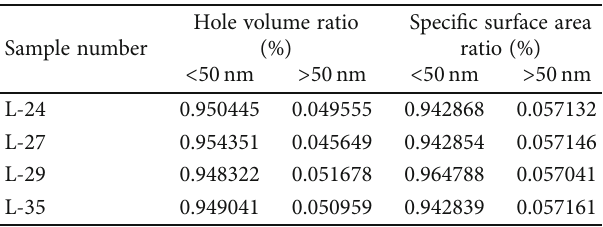
Figure 6: Stratigraphical distribution of the pore volume. Table 3: Surface area and pore volume values of the analyzed shale